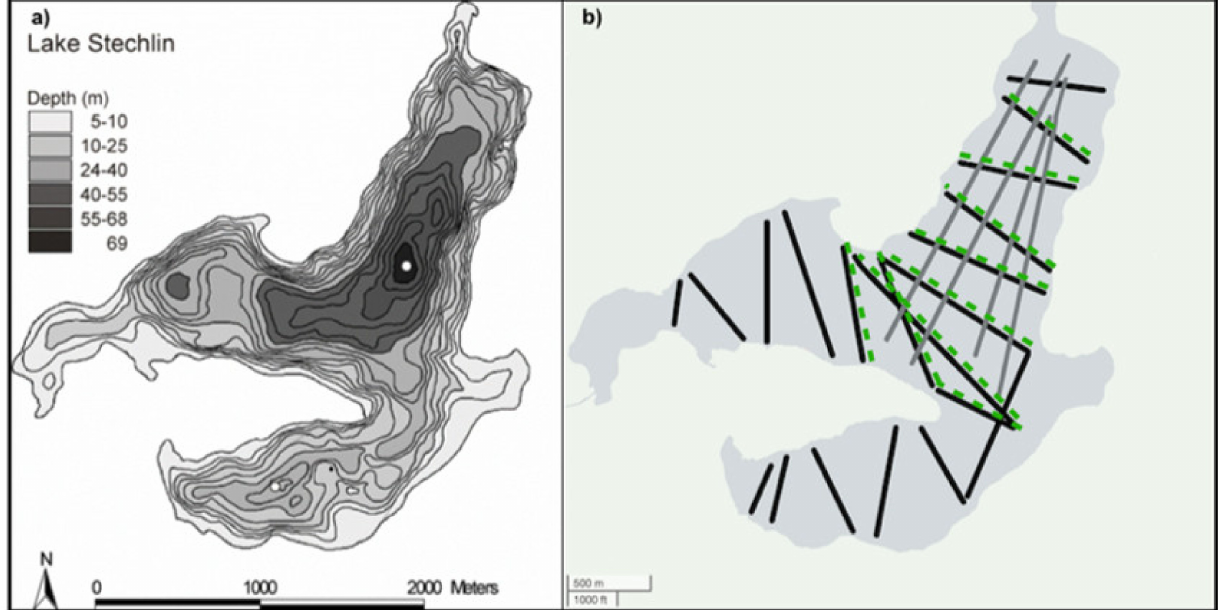
Figure 1. Bathymetric map of Lake Stechlin ( a ) and diagram with transects from hydroacoustic surveys of the whole lake (WL; black), midwater trawling (grey), and with transects from hydroacoustic surveys in the central and northern basin (CB) that overlap with trawling transects (green) ( b